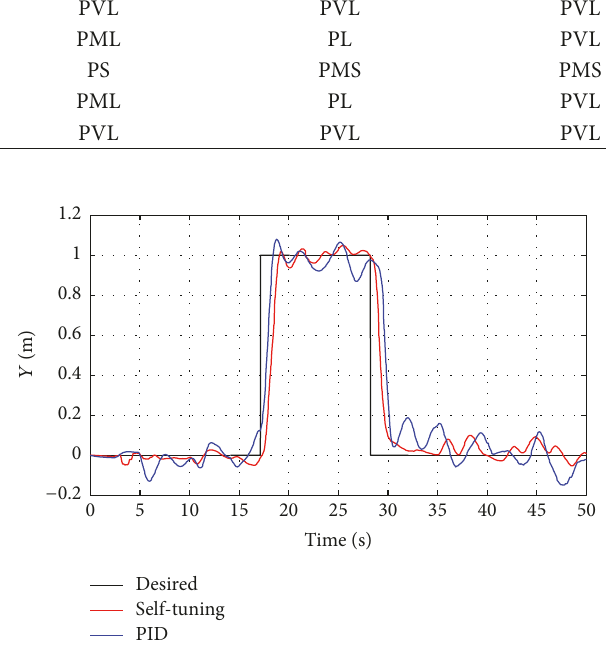
Figure 18: Quadrotor 𝑌 position under payload with variable